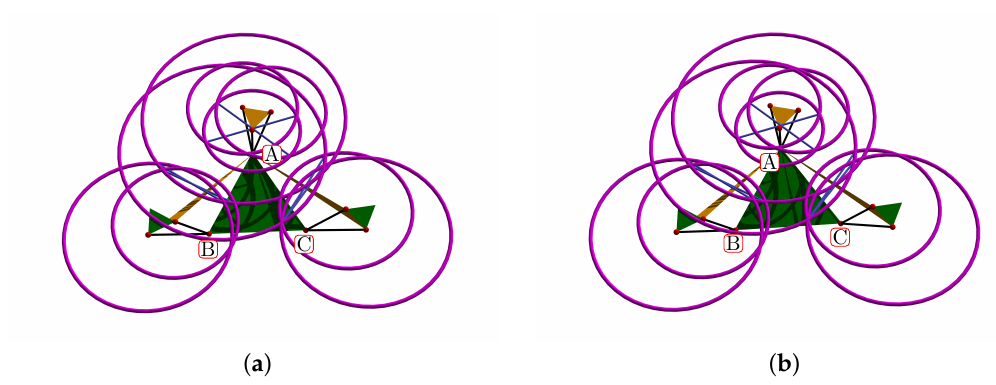
Figure 35. Latest two trilateration results: ( a ) position 3, ( b ) position 4.